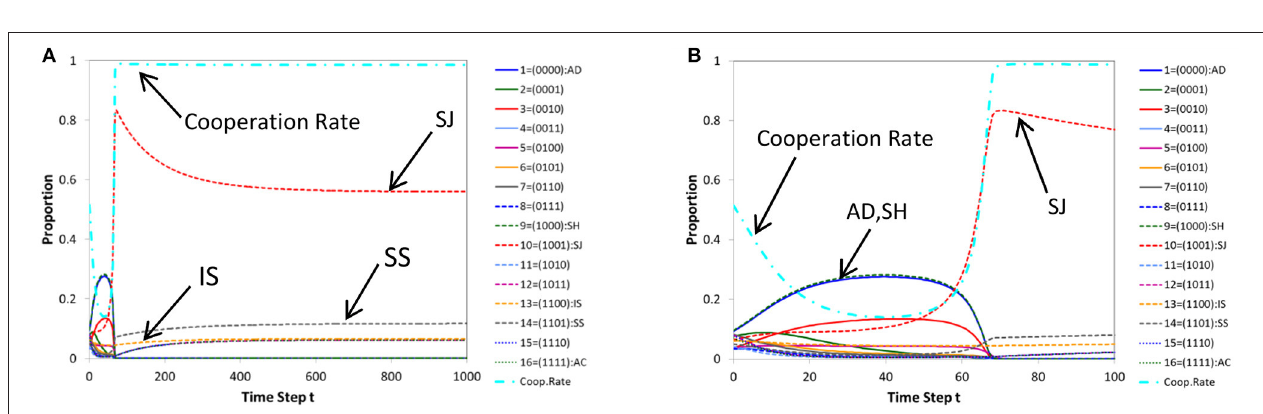
FIGURE 2 | A typical pattern of time evolution of norms’ frequencies and the cooperation rate in the population generated by replicator dynamics (A) and its initial part (the first 100 steps) (B) for a case where cooperation is achieved. Parameters: c = 1, b = 7, µ = 0.05, dt = 0.2.